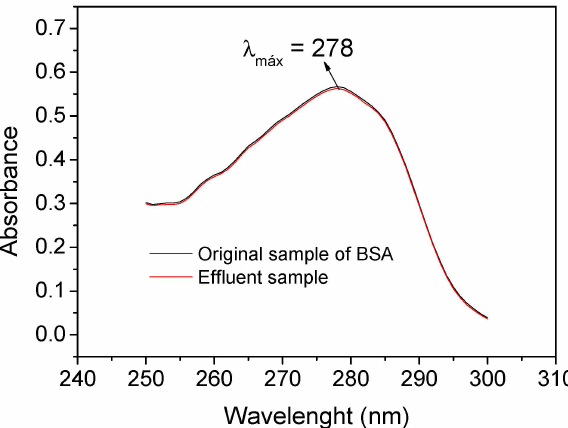
Figure 9. Absorption spectra in the ultraviolet region (240–310 nm) of 1.20 g L − 1 BSA solution at pH 6.0 buffered with 0.05 mol L − 1 BR (Original sample of BSA—black line) and of the column effluent from the preconcentration step (Effluent sample—red